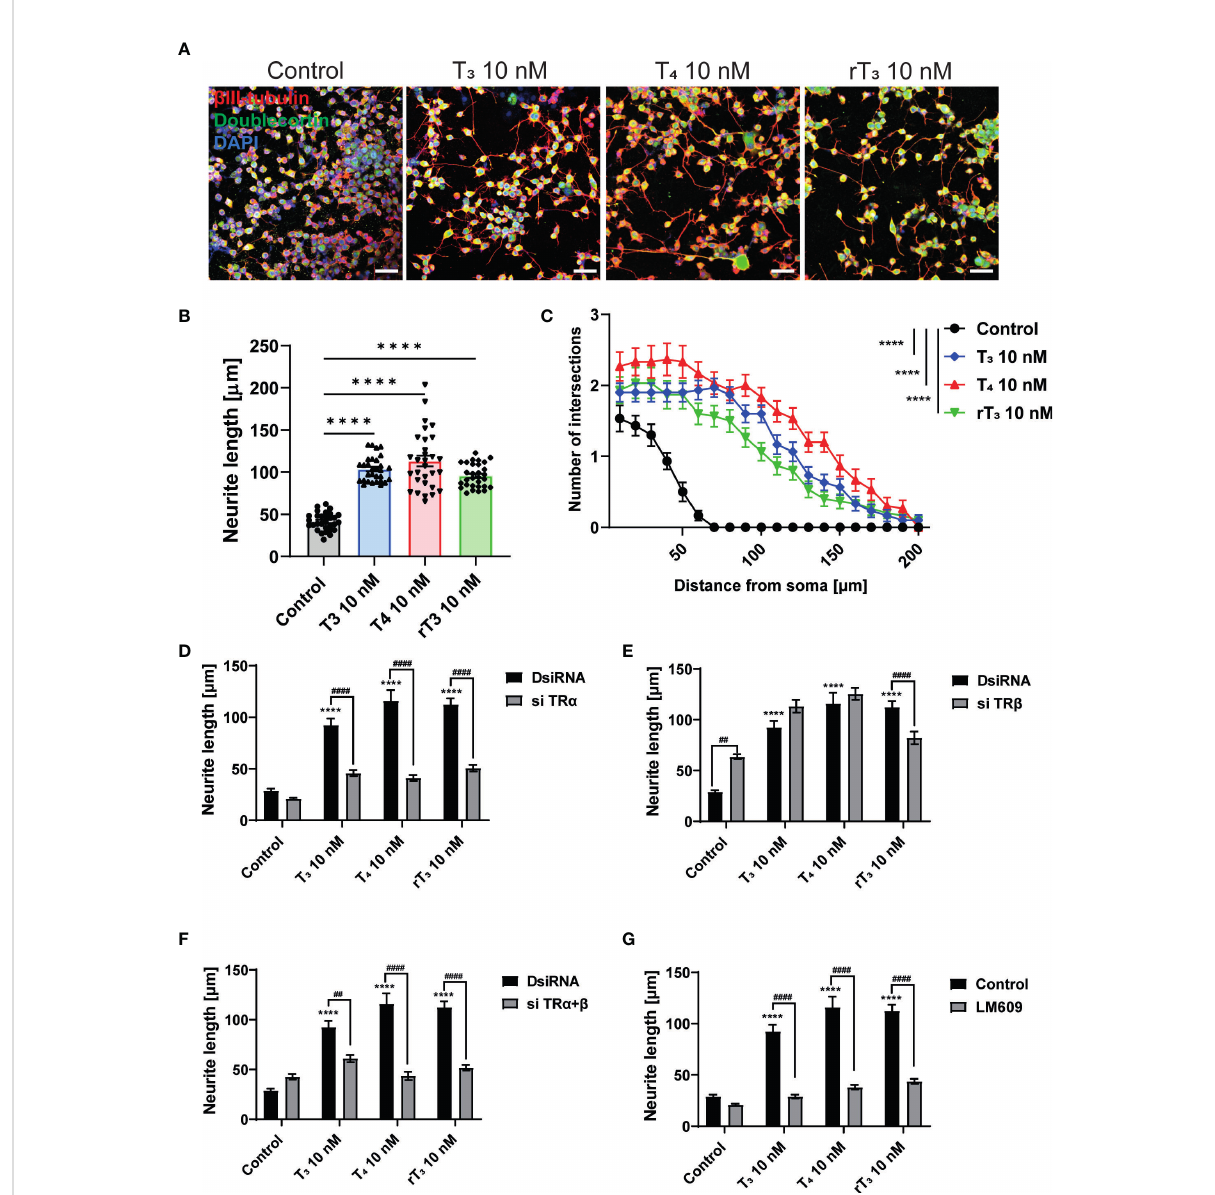
FIGURE 4 TR a and integrin a v b 3 affect neurite outgrowth induced by TH in neuronal-derived Neuro-2A cells. Cells were induced to differentiate by serum starvation for one to three days, followed by immuno fl uorescence analysis with b -tubulin III (red), doublecortin (green), and DAPI (blue). (A) Representative photomicrographs showing the effects of TH on the differentiation of Neuro-2A cells. (B) Changes in neurite lengths after TH exposure. (C) Quantitative analysis of the effect of TH on the number of neurite intersections at each concentric circle by Sholl analysis. Neurite length and Sholl analysis were quanti fi ed using ImageJ Fiji software (NIH). Bars indicate 50 m m. Quantitative analysis of the effect of TH after exposure to TRa siRNA (D) , TRb siRNA (E) , TRa and TRb siRNA (F) , and LM609 2 m g/mL (G) on neurite length in Neuro-2A cells. **** p < 0.0001, indicates statistical signi fi cance according to two-way or one-way ANOVA continued with post hoc Turkey test compared to control. #### p <0.0001 and ## p <0.01, indicate statistical signi fi cance according to two-way ANOVA continued with post hoc Bonferroni ’ s test. See Supplementary Table